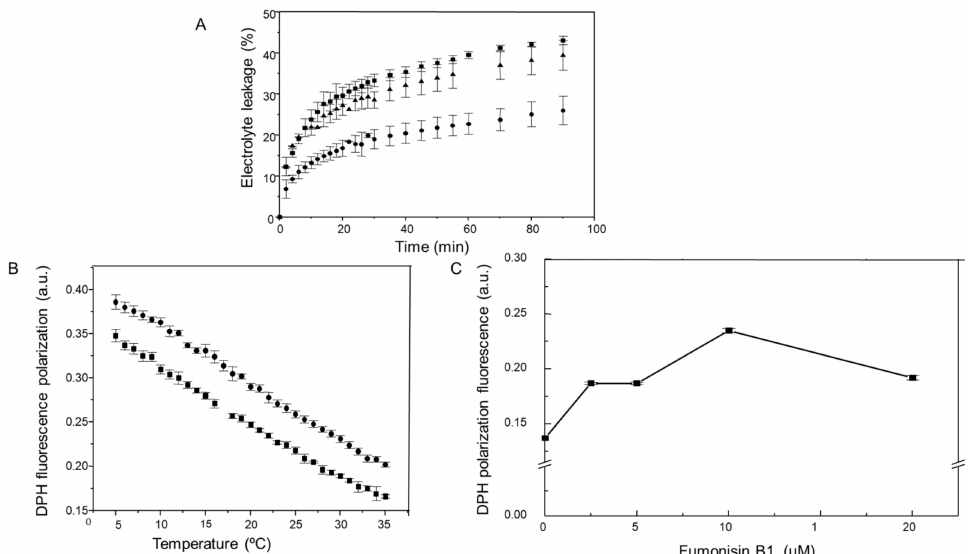
Figure 3. E ff ect of FB1 on permeability and fluidity of PM from maize embryos. ( A ) E ff ect of FB1 on maize embryo permeability. Twenty embryos were imbibed in 0 ( (cid:8) ), 10 ( (cid:78) ), 20 ( (cid:4) ) µ M FB1, then transferred to deionized water and electric conductivity measured as described under Experimental Procedures. Data represent means ± SD from 5–10 independent assays with at least three di ff erent embryo batches. ( B ) E ff ect of FB1 on the PM fluidity from maize embryos. Fluidity was measured in the PM isolated from maize embryos imbibed in the absence ( (cid:4) ), or presence of 10 µ M FB1 ( (cid:8) ) or ( C ) at the indicated FB1 concentrations for 24 h. Fluidity was measured by 1,6-diphenyl- 1,3,5-hexatriene (DPH) fluorescence polarization from 5 to 35 ◦ C ( B ) or at 30 ◦ C ( C ). Data represent means ± SD of at least three experiments done with a minimum of three di ff erent PM